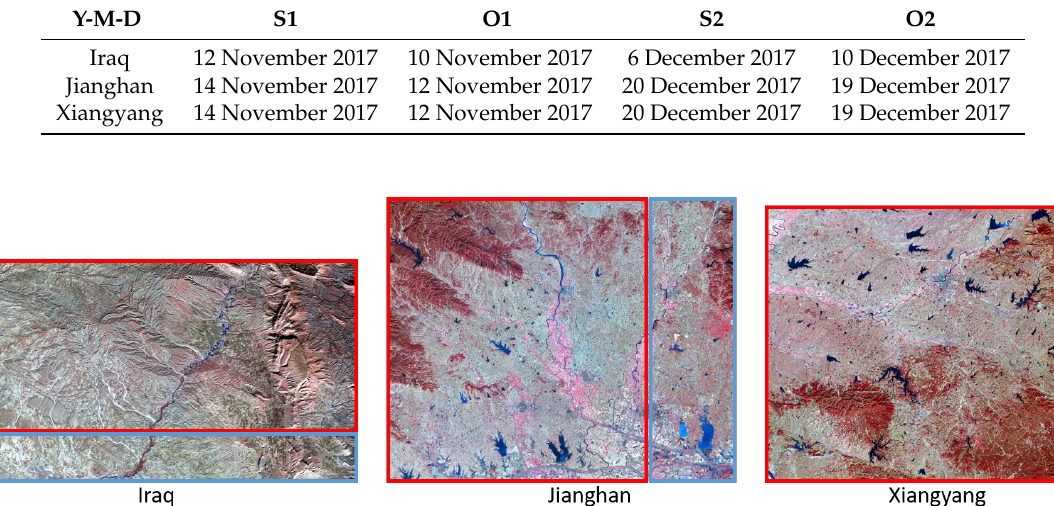
Figure 5. O2 images of Iraq, Jianghan and Xiangyang pairs. The training patches are selected from the red rectangle and the test patches are from the blue